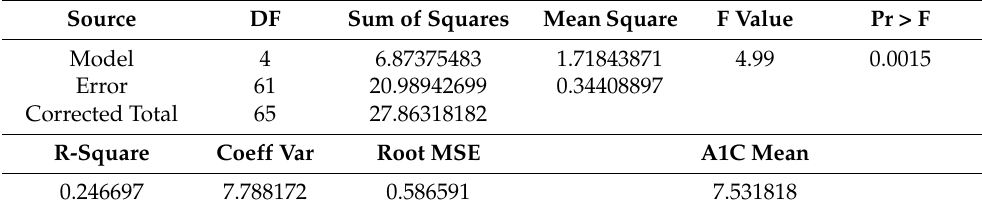
Table A9. GLM with A1C ≥ 7% as dependent variable.